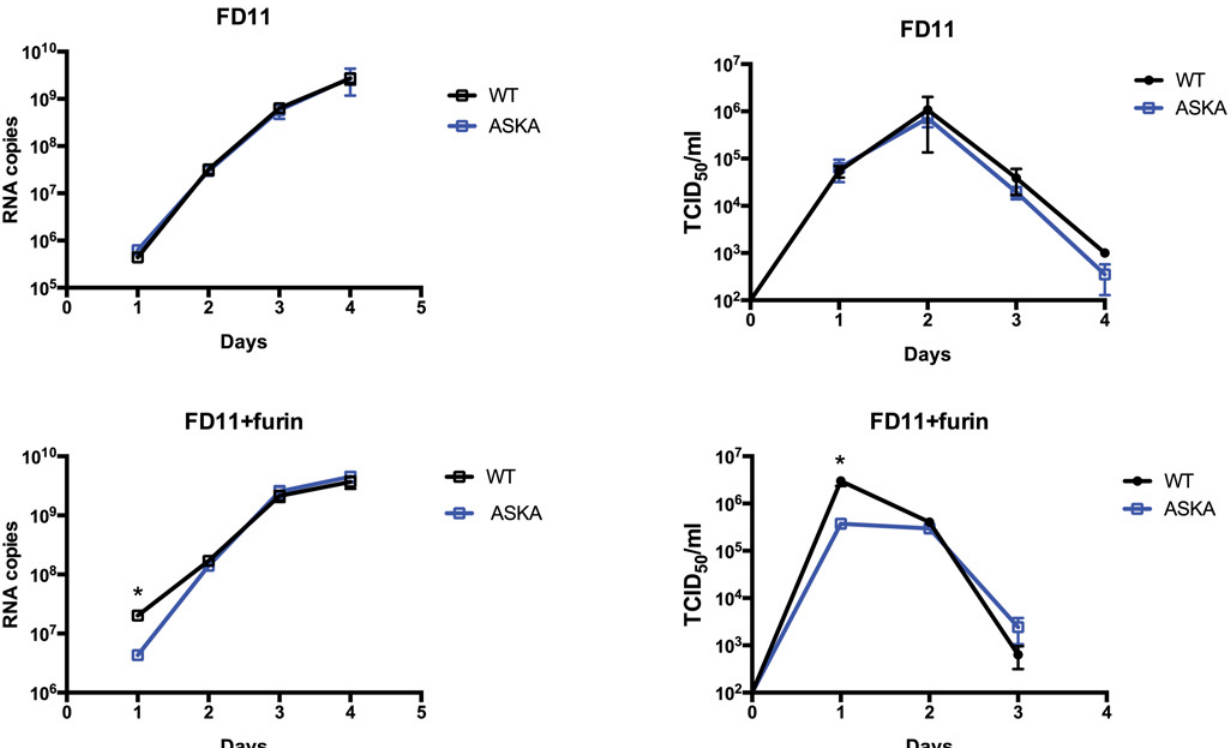
Fig 8. Furin effect on CCHFV-WT and-ASKA growth. FD11 and FD11-Fur cells were infected with CCHFV-WT or CCHFV-ASKA (MOI = 0.1). Cell supernatants were collected daily, and RNA S-segment copy numbers and infectious virus titers were measured by qRT-PCR and TCID 50 determination, respectively. Means ± standard deviation (n = 3) are plotted. Statistical significance was evaluated using Student ’ s unpaired t test. Asterisk ( * ) indicates P < 0.05.